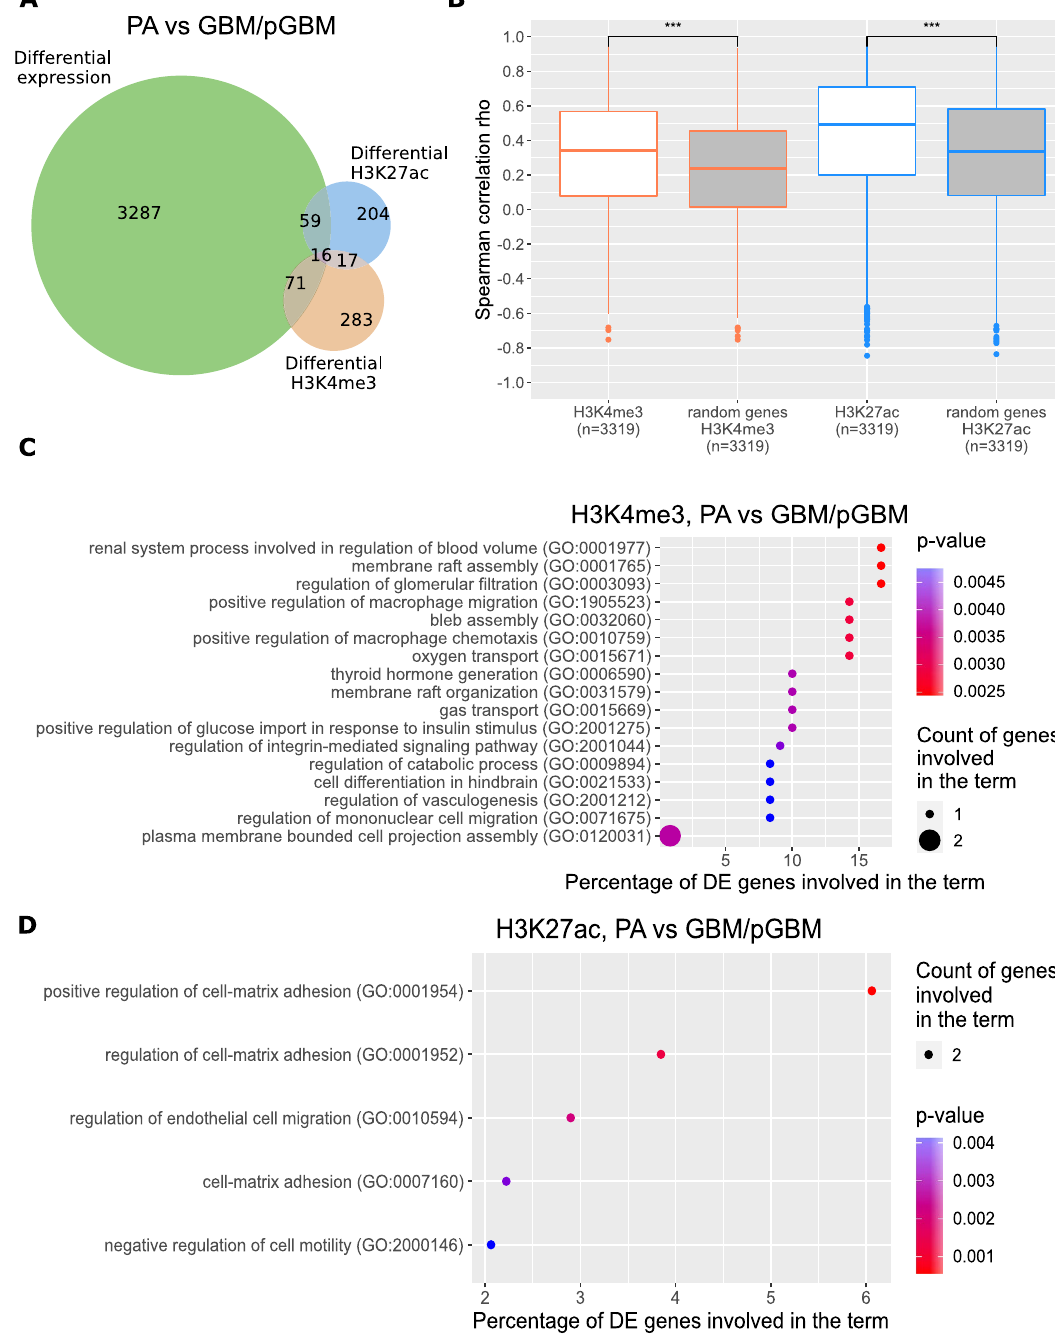
Figure 1. Identification of genes differentially expressed in benign and malignant gliomas (PA vs GBM/ pGBM). ( A ) Intersection of differentially expressed genes (DEGs) with genes carrying differential epigenetic modifications (DEMs) for the PA vs GBM/pGBM comparison. ( B ) Correlation of H3K4me3 (orange boxes) and H3K27ac (blue boxes) coverages at the promoters of DEGs (PA vs GBM/pGBM) with their expression. Boxes filled with white show values for DEGs, while in grey for the randomly chosen active genes. ( C ) Enrichment of Biological Process GO terms for DEGs in PA vs GBM/pGBM comparison having high correlation of expression levels with H3K4me3 (Spearman rho > 0.7), and being prognostic for glioma patients’ survival (log-rank test p < 0.001). ( D ) As in ( C ) for